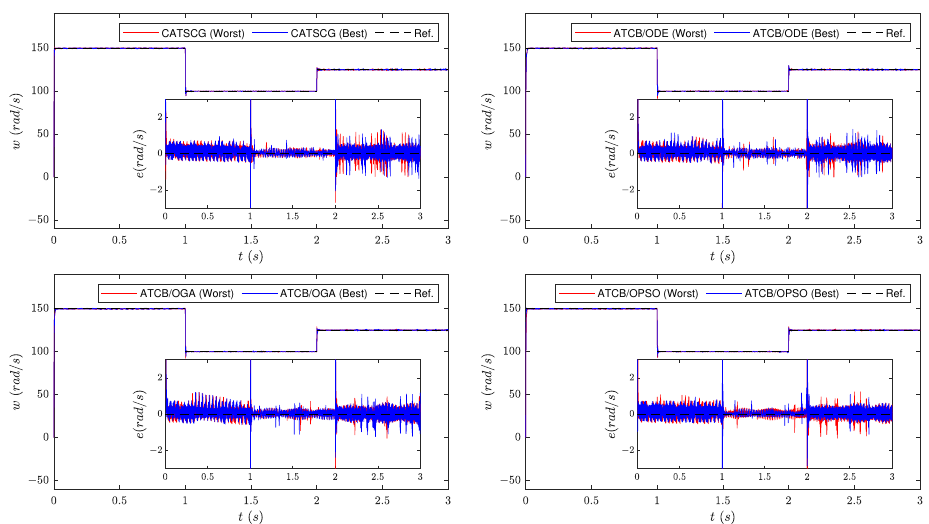
Figure 6. Speed output for the best and worst runs of the adaptive controller tuning, considering NOC.